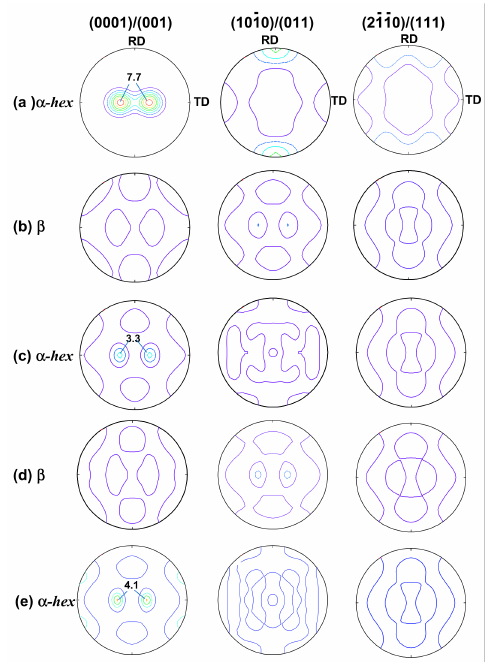
Figure 13. Pole figures of model ( a ) α -hex → ( b ) β → ( c ) α -hex → ( d ) β → ( e ) α -hex heating cycles. Contour levels are